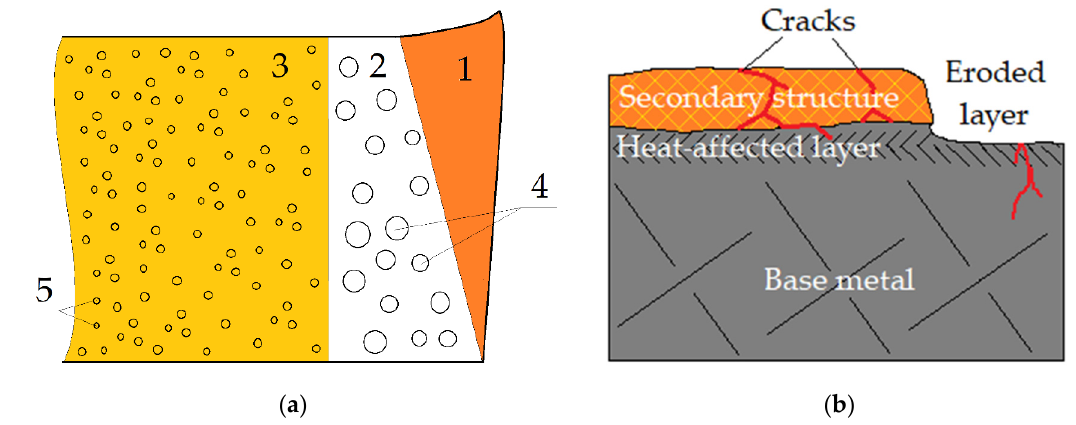
Figure 15. Submicrostructure and mechanism of material removal mechanism for electrical discharge machining of metals: ( a ) micro-chipping and burn marks on the surface of the sample at the end of the operation, where (1) is plastic deformation zone formed in the last microseconds of the operation under the weight of the workpiece, (2) is short circuit zone formed because of clamping the tool electrode between the workpiece and the detachable part (sample), (3) is regular machined surface, (4) is erosion wells after short-circuiting, (5) is regular erosion wells; ( b ) submicrostructure.